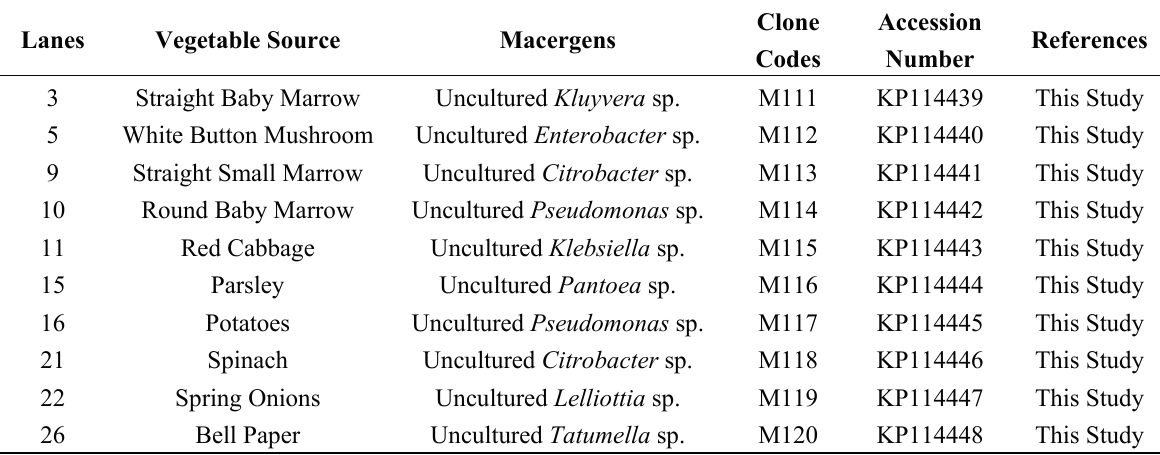
Table 2. Macergens detected by Set 1 and Set 4 primers from the rotten vegetables.